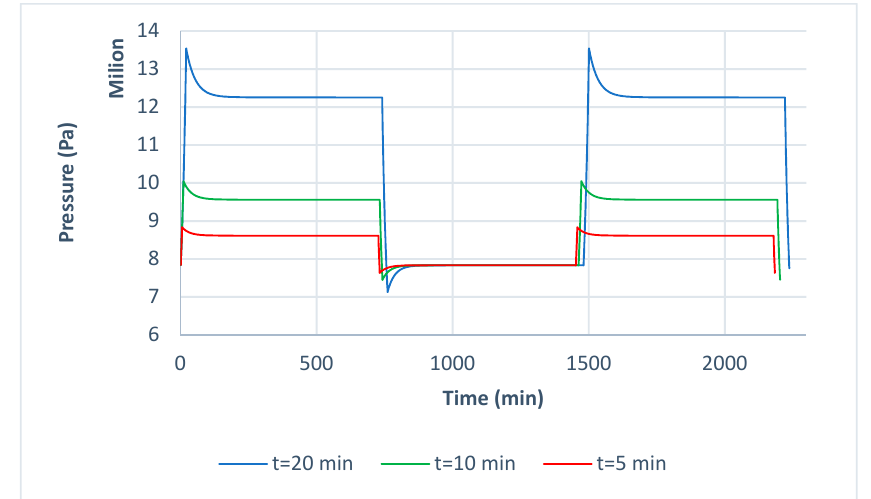
Figure 18. Gas pressure trend for the First Configuration varying the charging time .